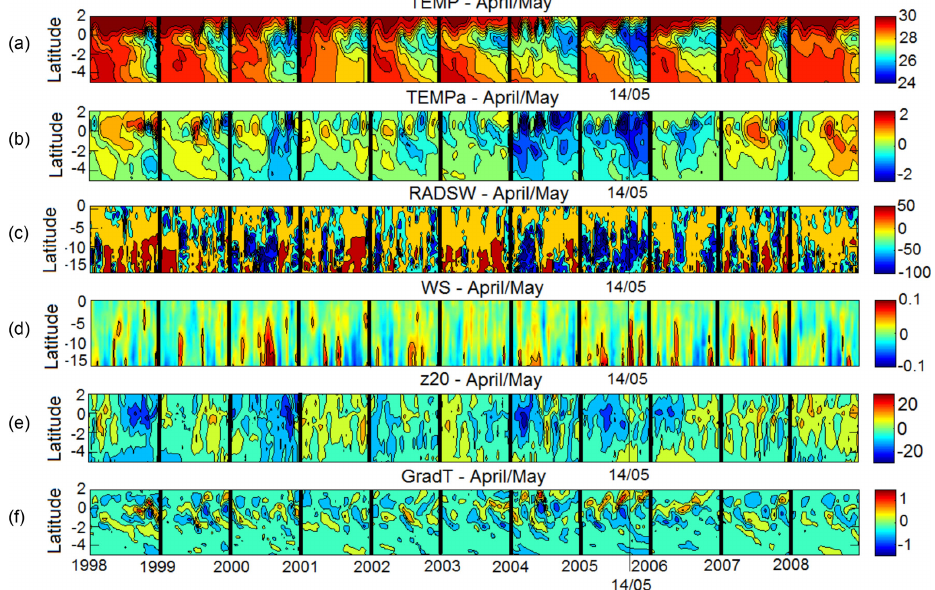
Figure 12. Time–latitude diagrams for April–May along the 1998–2008 period of 2-day averages. From top to bottom: (a) SST ( ◦ C); (b) intraseasonal anomaly of SST ( ◦ C); (c) intraseasonal anomaly of shortwave radiation surface flux (Wm − 2 ) from CFSR fields ; (d) in- traseasonal anomaly of wind stress magnitude (Nm − 2 ) from CFSR fields; (e) intraseasonal anomaly of 20 ◦ C isotherm depth (m) computed from the forced model SST; (f) intraseasonal anomaly of meridional SST gradient (every 0.5 ◦ of latitude) from the forced model averaged over 10–6 ◦ W. The thin vertical black line indicates the date of 14 May 2005. For details about the calculations of the anomalies, see Sect.